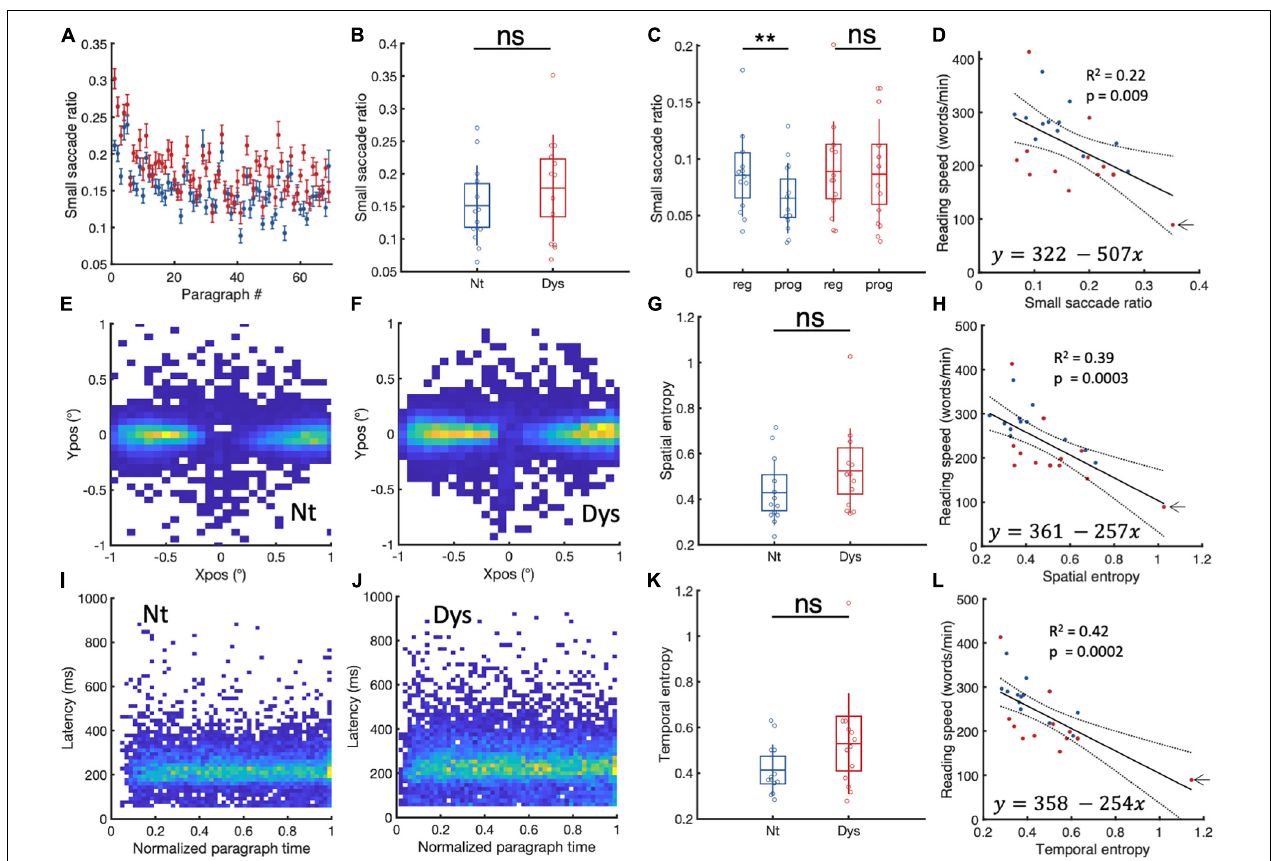
FIGURE 4 | Small saccade occurrences and spatiotemporal entropy. (A) Paragraph specific small saccade ratios in neurotypicals (blue) and dyslexics (red). (B) Subject specific small saccade ratios for neurotypicals (blue) and dyslexics (red). (C) Comparison between regressive and progressive subject specific small saccade ratios for neurotypicals (blue) and dyslexics (red). (D) Linear regression analysis of small saccade ratios and reading speed. Small saccade landing point distributions for (E) neurotypicals and (F) dyslexics. (G) Subject specific small saccade spatial entropy for neurotypicals (blue) and dyslexics (red). (H) Linear regression analysis of small saccade spatial entropy and reading speed. (I,J) Small saccade temporal occurrences in neurotypicals and dyslexics, respectively. (K) Subject specific temporal entropy for neurotypicals (blue) and dyslexics (red). (L) Linear regression analysis of temporal entropy and reading speed. * p < 0.05, ** p < 0.01, and *** p < 0.001. ns > 0.05